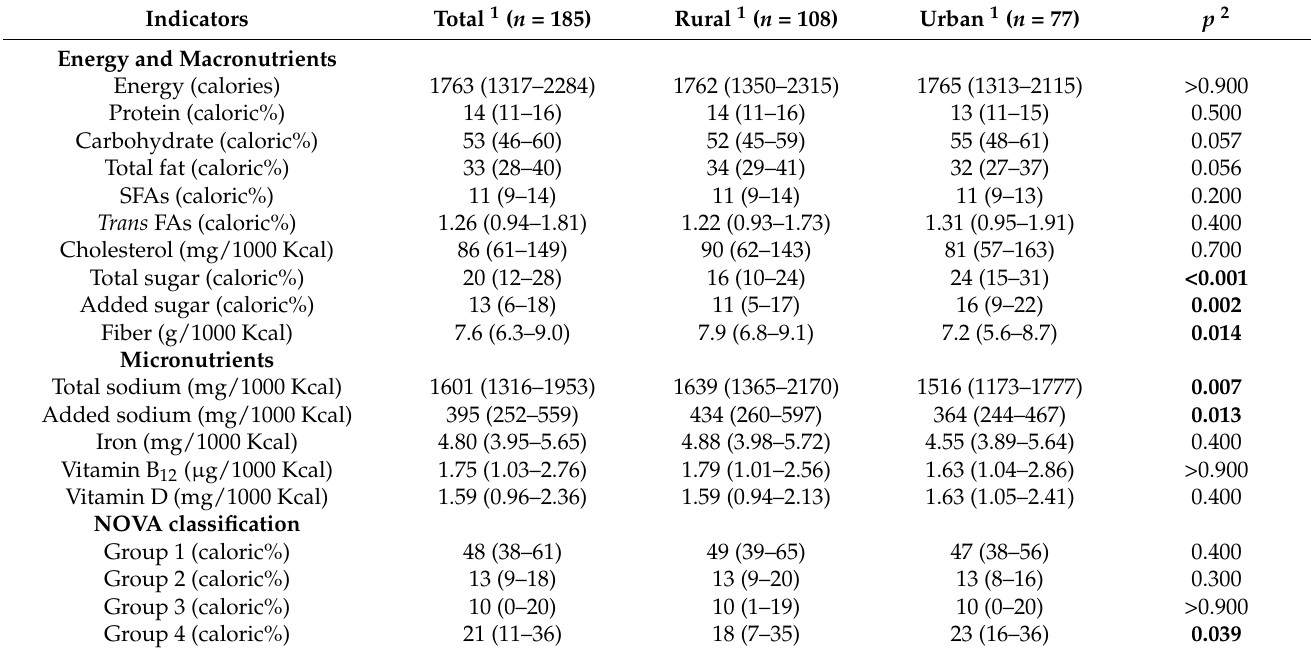
Table 1. Quantitative and qualitative nutritional characteristics of food consumption of the partici- pants according to the school